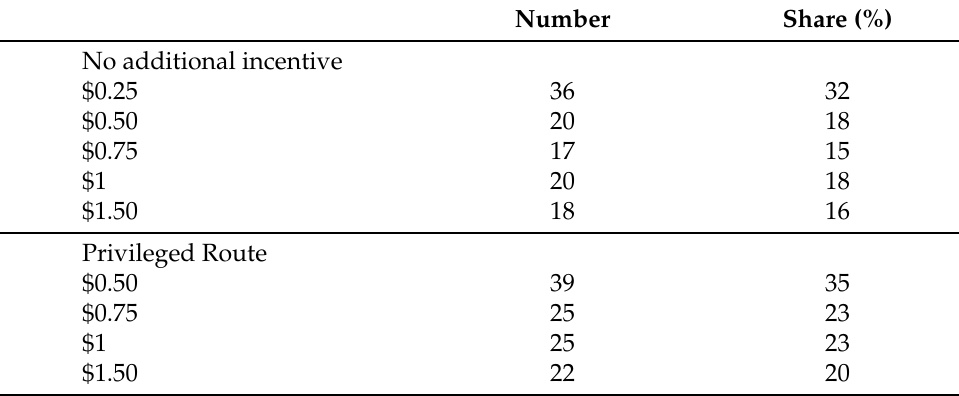
Table 7. Maximum additional fee for